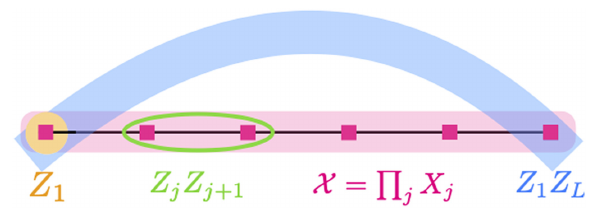
FIG. 10. The repetition code. The 1D repetition code on a chain of length L . The green oval indicates the stabilizer genera- tor Z j Z j + 1 while the logical operators are Z 1 (orange circle) and (cid:5) X = L X j (magenta shaded). The global code has stabilizer (cid:5) j = 1 L Z j Z j + 1 = Z 1 Z L (blue j = 1